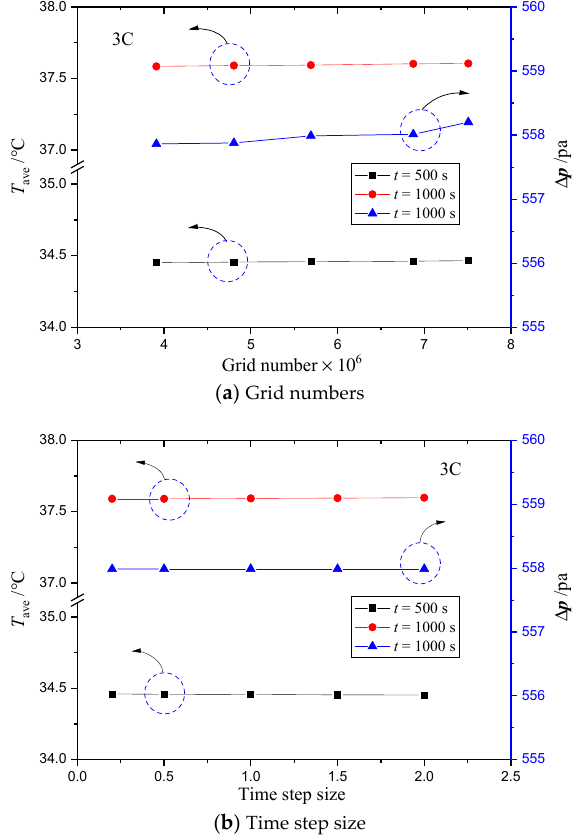
Figure 5. The change in the average battery temperature and pressure difference between inlet and outlet for cold plate with increasing ( a ) grid numbers and ( b ) time step.